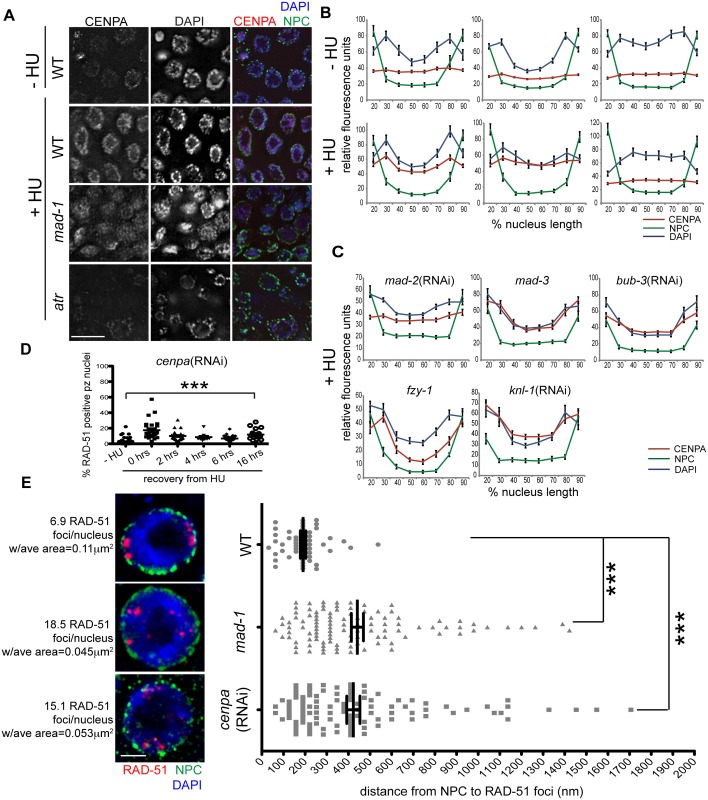
CENPA is regulated by both DDR and SAC components and is required for recruitment of RAD-51 to the nuclear periphery and efficient DNA damage repair.(A) Proliferative zones of wild-type, mad-1(gk2) and atr(tm853) worms treated with HU and stained for CENPA (red), Mab414 (NPC) (green) and DAPI (blue). (B) Quantification of the average fluorescence intensity of CENPA, MAb414, and DAPI across the nucleus length binned in 10% increments-HU for wild type, mad-1(gk2)and atr(tm853), and +HU for the above genotypes (n≥30). (C) Quantification of the average fluorescence intensity of CENPA and Mab414 across the nucleus length binned in 10% increments for mad-2(RNAi), mad-3(ok1580), bub-3(RNAi), knl-1(RNAi) and fzy-1(av15) in the presence of HU (n≥30). (D) Percent of nuclei that contain at least 1 RAD-51 focus—HU or 0, 2, 4, 6, or 16 hours after release from 5mM HU with cenpa(RNAi); n≥10. Scale bars 10μm. (E) SIM images of a single nucleus from wild-type, mad-1(gk2) and cenpa(RNAi) worms treated with HU. Next to each image is the average number of RAD-51 foci observed in each genotype, as well as the average area of each RAD-51 focus (n = 4 germ lines). Images represent a projection of 3 z sections. Graph indicates the distance in nanometers between NPC and RAD-51 foci in wild-type, mad-1(gk2) and cenpa(RNAi) worms after HU. Scale bar 2 μm. Error bars indicate SEM. ***p<0.0001